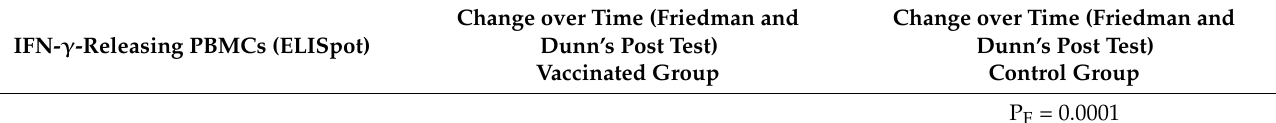
Table A6. Results of the Friedman and Dunn’s post test of IFN- γ -releasing PBMCs in vaccinated and control after FCV Challenge I measured by ELISpot.